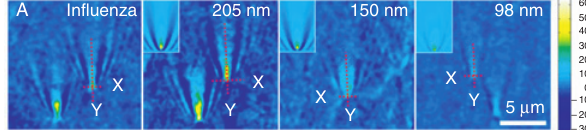
Figure 4: Individual influenza virus particles and differently sized silica nanoparticles are immobilized onto a chromium and gold- coated coverslip and detected with surface-plasmon resonance microscopy. SPR waves induced by TIR illumination are diffracted by any inhomogeneities in the gold. Adapted from